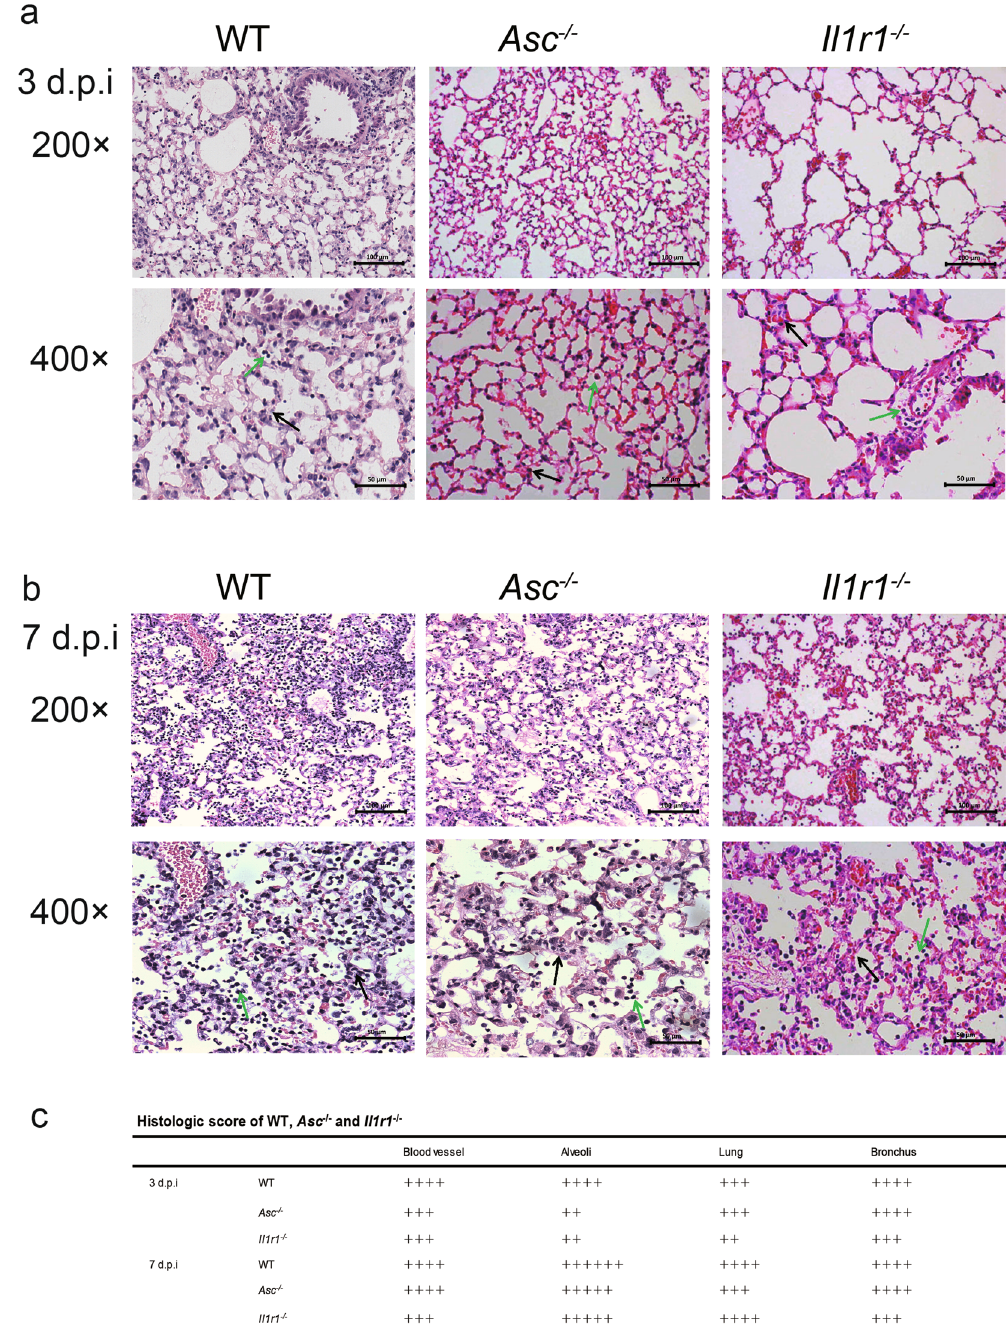
Figure 7. Deficiency of the ASC or IL-1 receptor decreases pulmonary inflammation upon H7N9 infection. ( a,b ) WT or Asc − / − , Il1r1 − / − mice were infected as in Fig. 2 and the lungs were harvested on 3d.p.i or 7d.p.i, then the tissues were fixed and processed for H&E staining and microscopic analyses. The original magnification of the top panels and the bottom panels are 200 × and 400 × (with the corresponding scale bar on the images). In the 400 × magnification, the black arrows indicate the thickening of alveolar septum and the green arrows show inflammatory cells infiltration. ( c ) For scoring results of pulmonary pathology of WT, Asc − / − and Il1r1 − / − mice, 4 slides from each mouse were monitored. 4 mice representing each genotype at specific time points were used for experiments. Data are representative of three independent infection